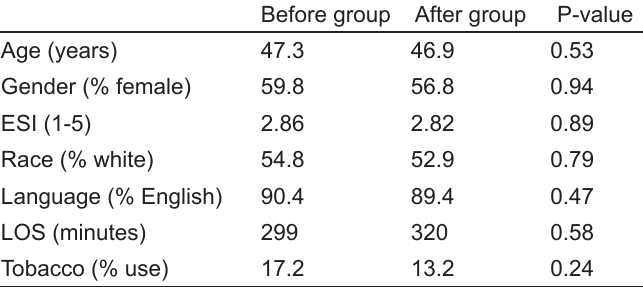
Table 1. Characteristic comparison between the before and after implementation of the automated discharge instructions